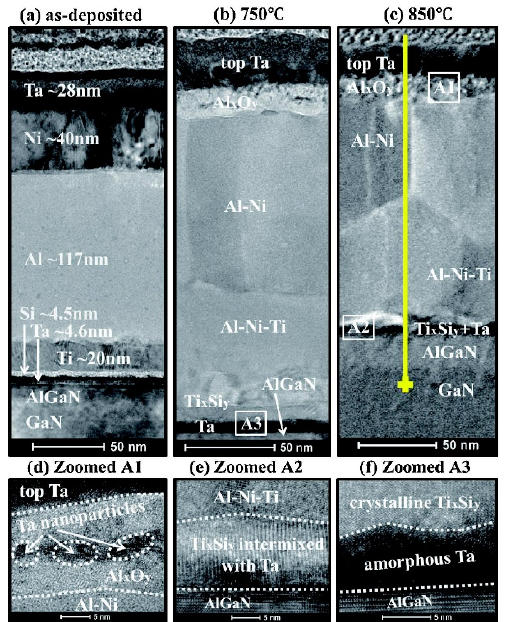
Figure 9. Cross sectional high-resolution TEM images of ( a ) as-deposited, ( b ) 750 °C-annealed, ( c ) 850 °C-annealed non-gold ohmic contacts. ( d , e ): zoomed-in TEM images of Ta/Ni interface (A1) and metal/AlGaN interface (A2) of 850 °C-annealed non-gold contact in ( c ), respectively, and ( f ): zoomed-in TEM image of metal/AlGaN interface (A3) of 750 °C -annealed non-gold (Ta/Si/Ti/Al/Ni/Ta) ohmic contact in ( b ) . Reprinted with permission from Ref. [82]. Copyright 2013, IOP science.